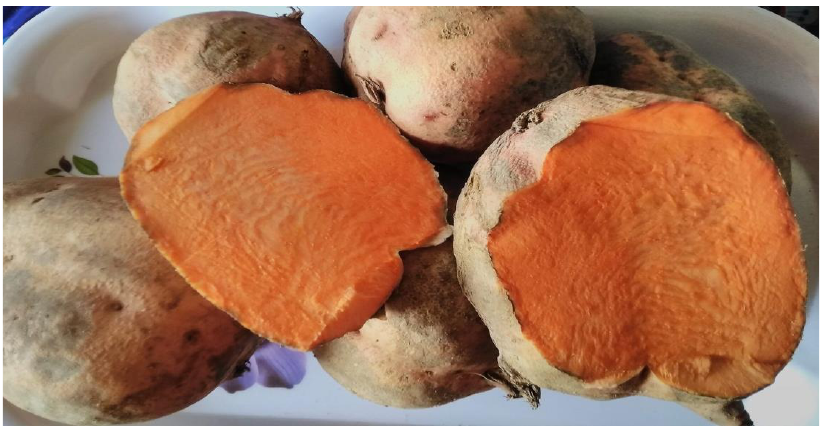
Figure 2. Orange-fleshed sweet potato.